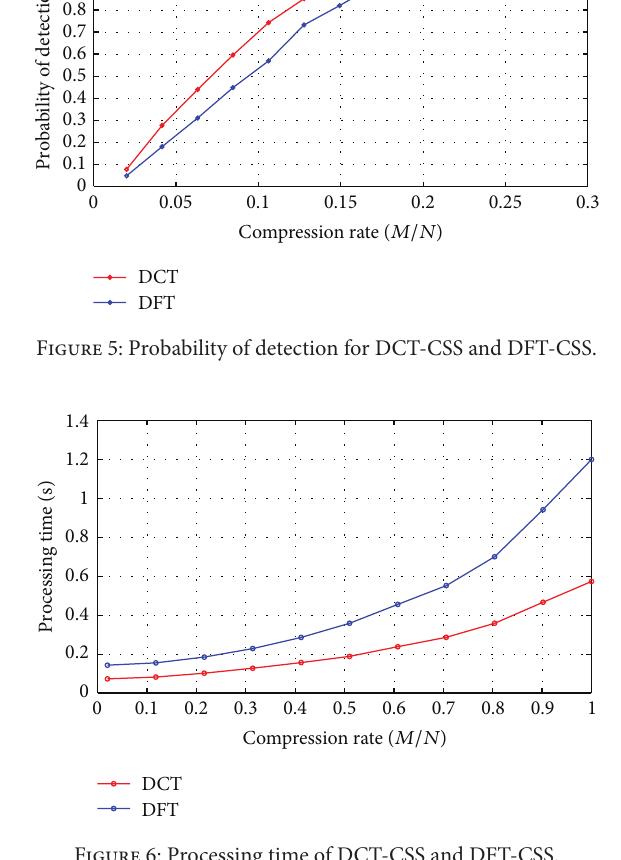
Figure 6: Processing time of DCT-CSS and